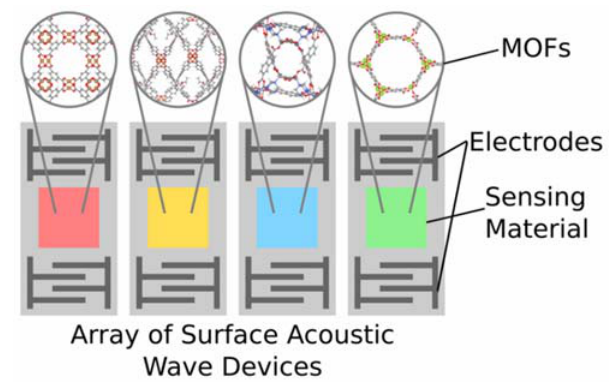
Figure 1. Sample four-element array of surface acoustic wave devices with MOFs as sensing materials.